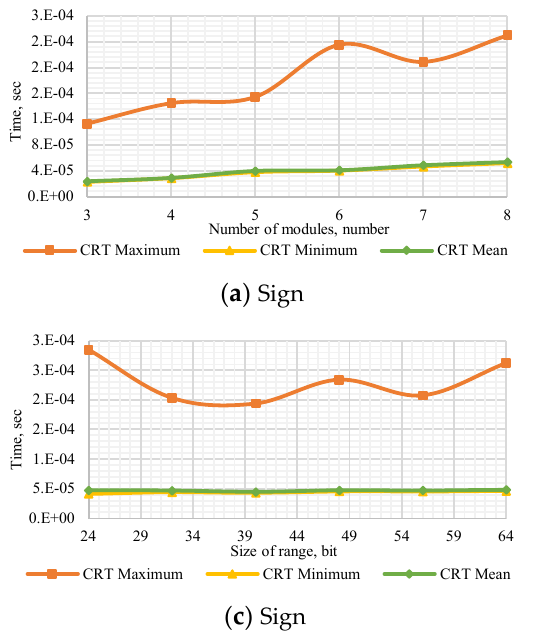
Figure A1. Performance of CRT method to ( a ) determine the number’s sign with a dynamic number of modules p , ( b ) compare dynamic numbers of modules p , ( c ) determine the number’s sign with a dynamic bit width, and ( d ) compare numbers with dynamic bit width.